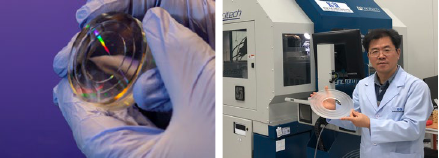
Fig. 4. MODE lens prototypes designed and fabricated with two diffractive surfaces of a front MODE surface and a single-order diffractive lens back-surface (left) [4] and a direct diamond turned 240 mm diameter MODE lens prototype